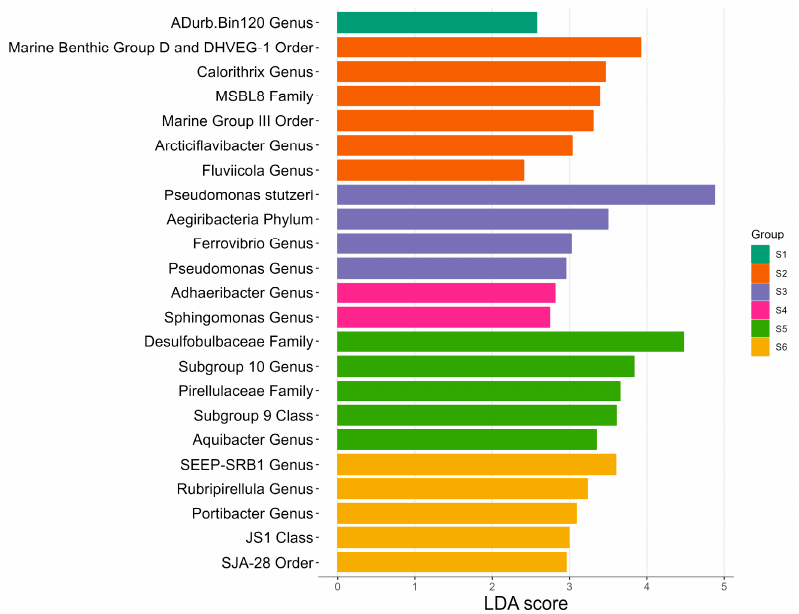
Figure 5. Differential abundances analysis (LEFSE) at species and upper levels for all sampling stations (S1–S6) using triplicate data for each site. An LDA score threshold = 2 was applied. Site S4 was more abundant for Sphingomonas ( Alphaproteobacteria ) and Adhaeribacter ( Bacteroidetes ) whereas Pseudomonas stutzeri , Aegiribacteria phyla and Ferrovibrio